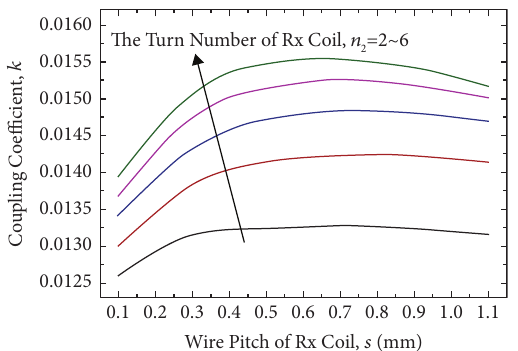
Figure 5: Simulation results for k of WPT with a solenoid Rx coil. The turn number of Rx coil n 2 is swept from 2 to 6, and the wire pitch of Rx coil s is swept from 0.1mm to 1.1mm. A single-turn circular Tx coil is used, R 1 � 20mm and r 1 � 0.287mm. For the Rx